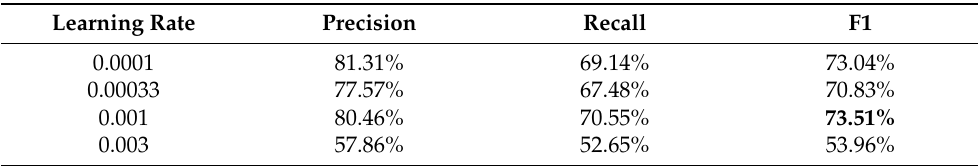
Table 5. Comparison of different learning